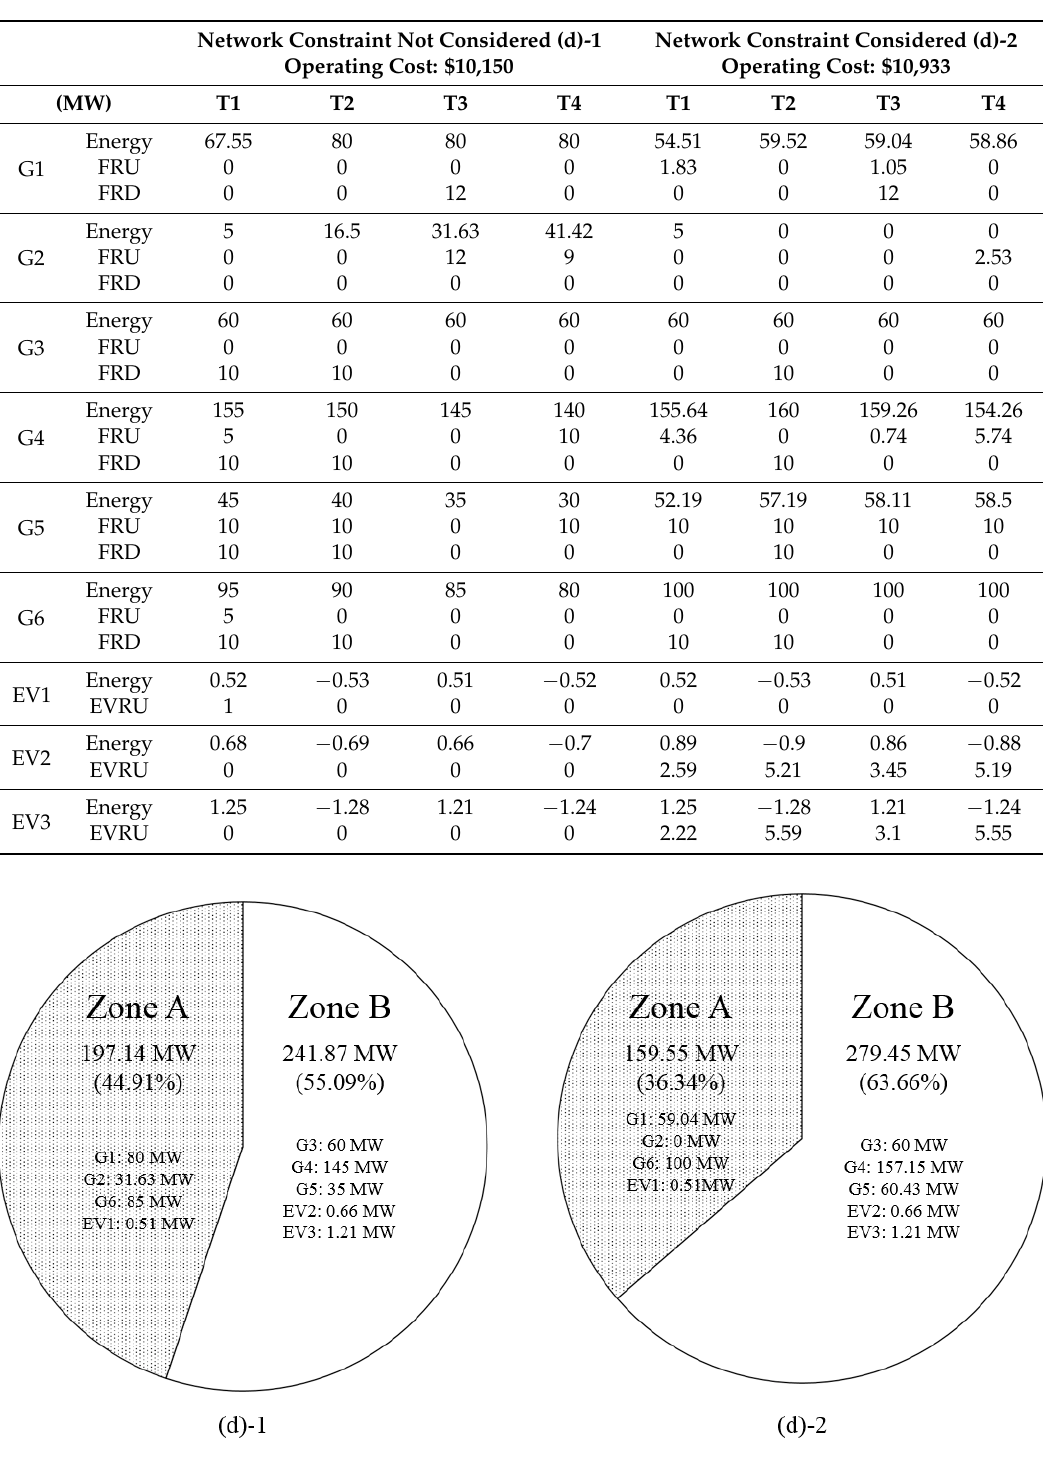
Table 7. Dispatch cleared products for case (d).